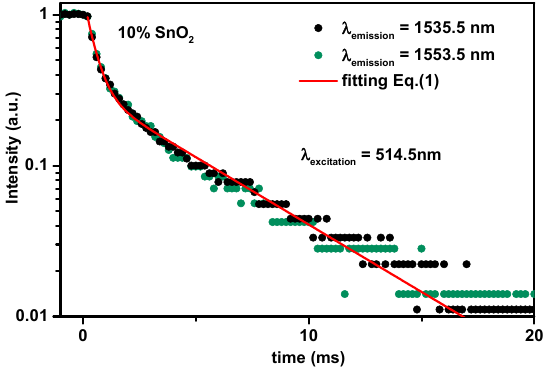
Figure 6. Decay curves of the luminescence from the 4 I 13/2 metastable state recorded at 1535.5 nm (black dots) and 1553.5 nm (green dots), acquired using the 514.5 nm Ar + laser beam, of Er 3+ in 90SiO 2 -10SnO 2 :0.5Er 3+ monolith heat treated at 900 ◦ C for 40 h. The fitting curve is acquired based on Equation